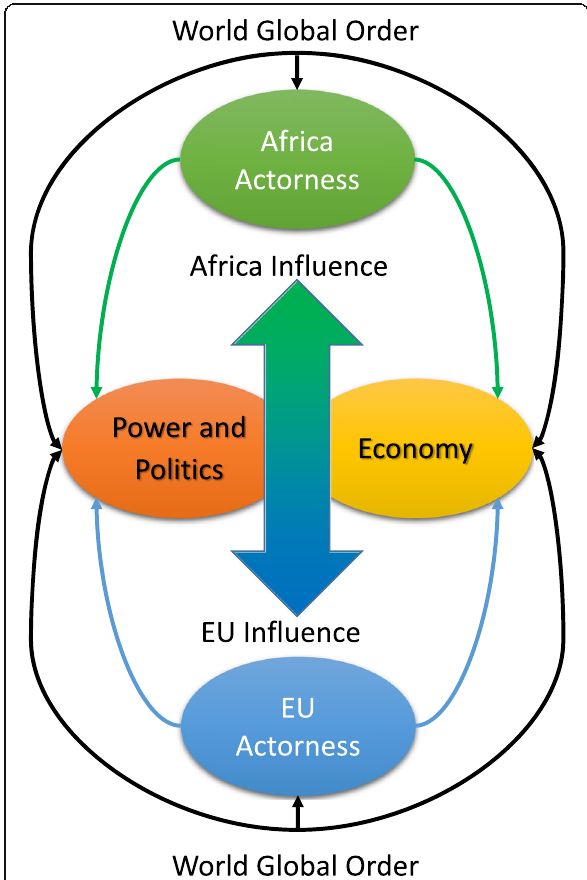
Fig. 1 The EU-Africa relationship in global context. Source: